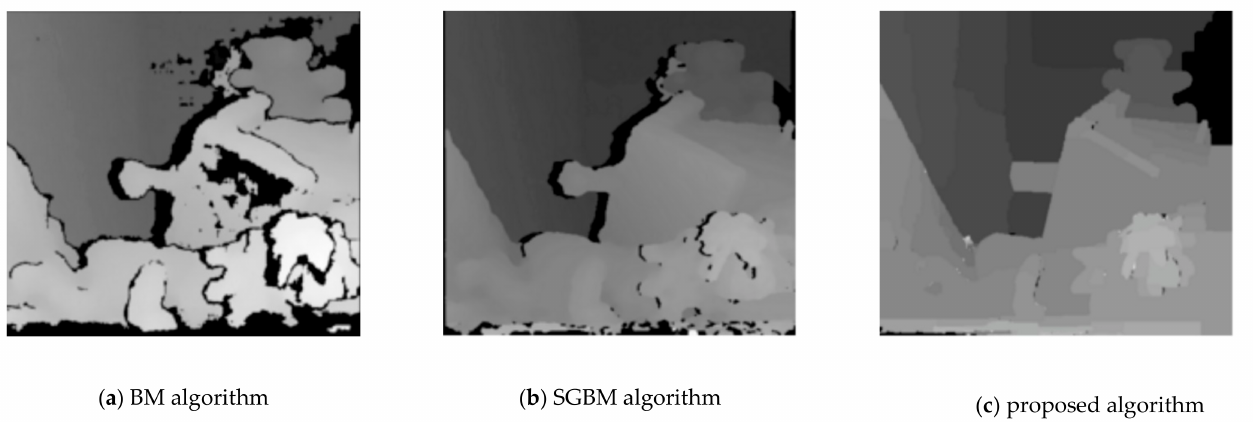
Figure 16. The disparity estimation results of BM, SGBM and the proposed algorithm.